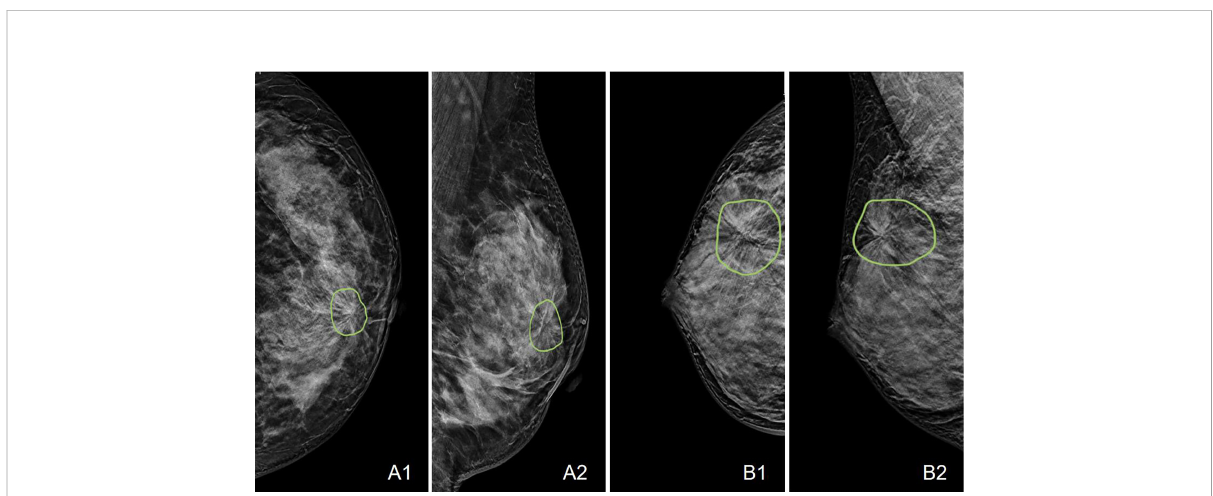
FIGURE 2 Case examples showing the typical architectural distortion. A : The LCC and LMLO views of a 53-year-old patient diagnosed with invasive ductal cancer. The BI-RADS score is 4B. The radiomics score of the combined model is 0.65, correctly diagnosing this case as malignant, true-positive. B : The RCC and RMLO views of a 42-year-old patient diagnosed with sclerosing adenosis. The BI-RADS score is 4C. The radiomics score of the combined model is 0.48, correctly diagnosing this case as benign, true-negative.